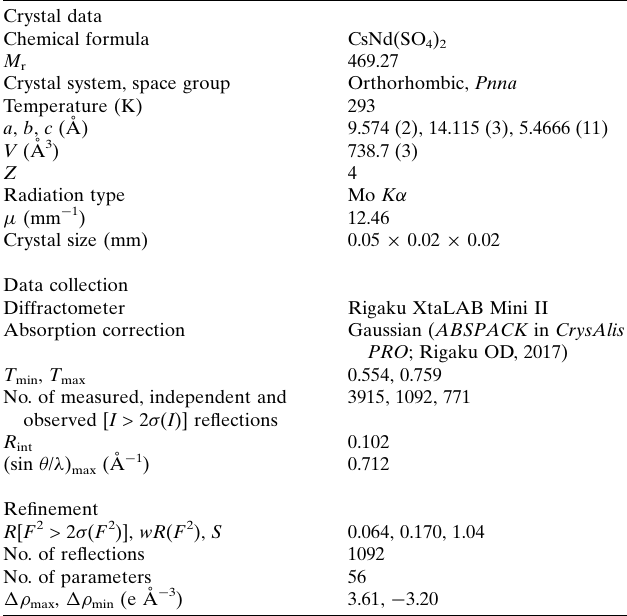
Table 3 Experimental details. Crystal data Chemical